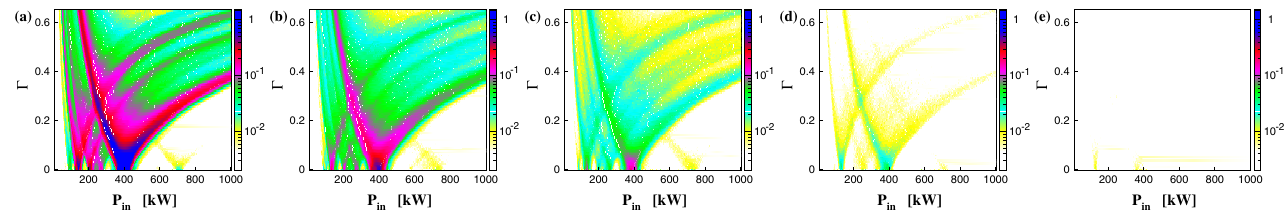
FIG. 6. Multipactoring zone maps for depths of (a) 0.6 mm, (b) 0.8 mm, (c) 1.0 mm, (d) 1.2 mm, and (e) 1.4 mm and for a pitch of 2.0 mm, where the corresponding MPmax values are shown in Fig.